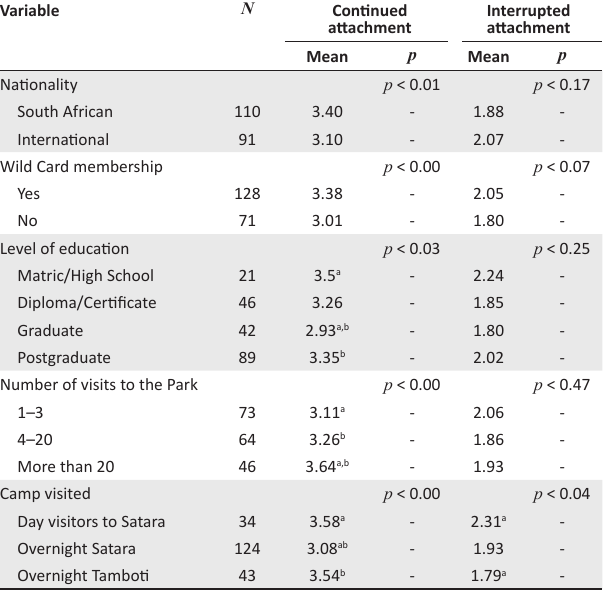
Note: Superscripts with different letters indicate a significant difference between means at a 5 % level of